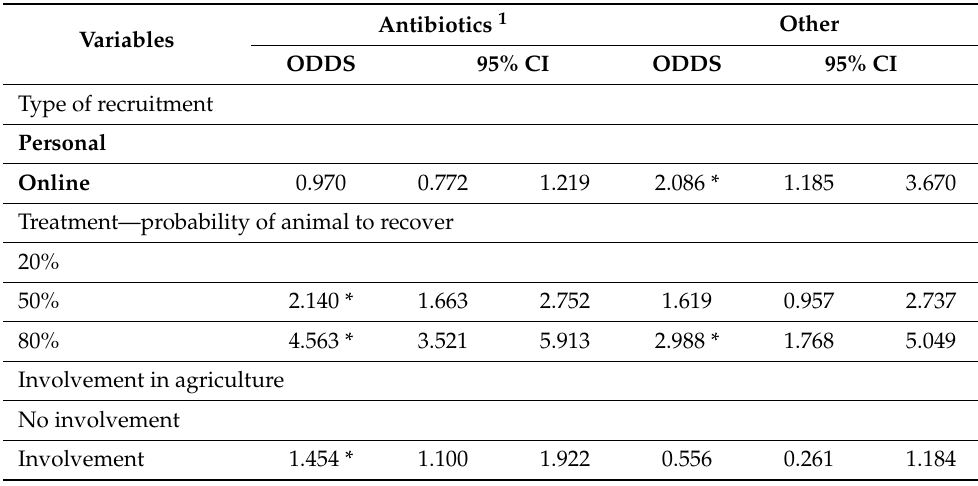
Table 4. Odds ratio (ODDS) and 95% confidence interval (95% CI) for multinomial logistic regression models of opinion towards the most appropriate solution for unhealthy pigs with different probabili- ties of recovery after treatment (Q4). The reference category was “To euthanize this pig on the farm after the disease is